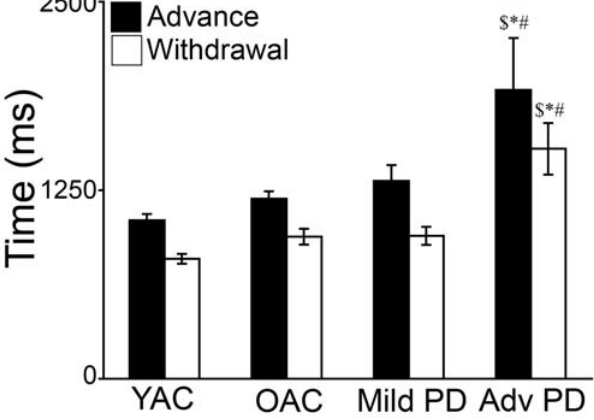
Figure 2. Time (mean and standard error) to complete advance and withdrawal for the four experimental groups. $ =advanced PD . YAC; *=advanced PD . OAC; ## =advanced PD . mild PD and # ps , 0.001.